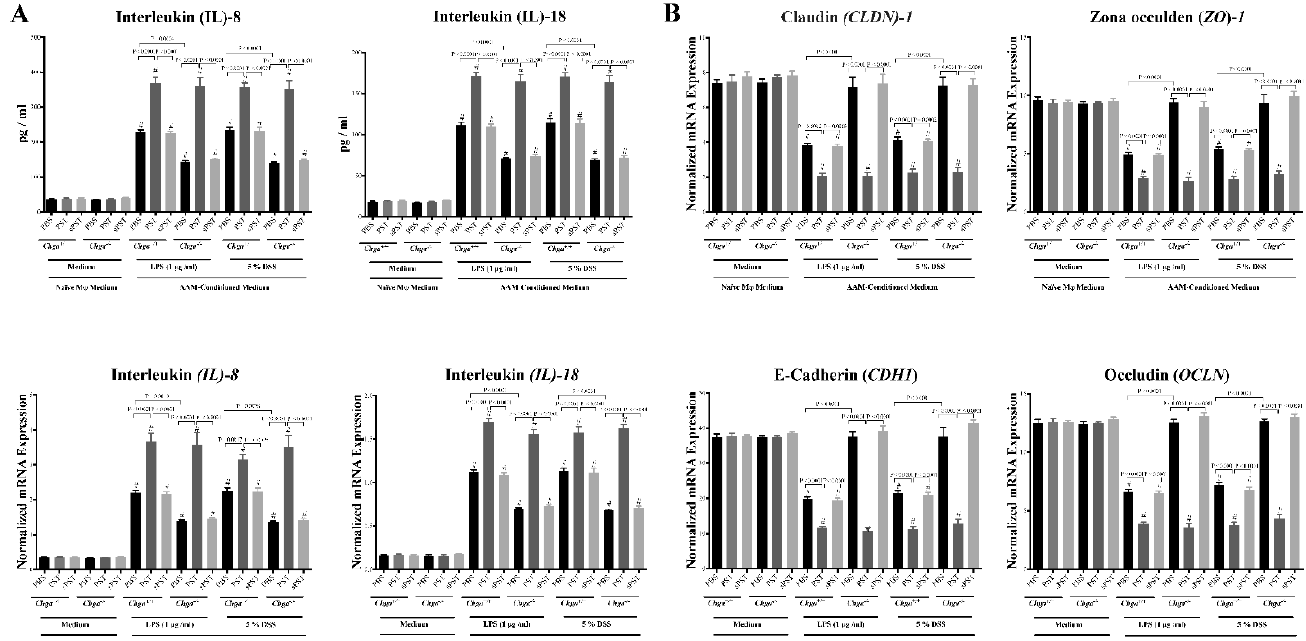
Figure 7. Conditioned medium isolated from pancreastatin (PST) pretreated naïve macrophages polarized toward an alternative-activated macrophages profile (AAM) increases IL-8 and IL-18 release and disrupts TJ proteins expression in Lipopolysaccharide (LPS)- and dextran sulfate sodium (DSS)-stimulated colonic epithelial cells. Peritoneal macrophages were isolated from naïve Chga +/+ and Chga − / − mice. Macrophages were pretreated with PST or sPST (200 ng/mL) or 1% PBS for four hours, then stimulated by interleukin (IL)-4/IL-13 (20 ng/mL) for six hours and conditioned medium was harvested. Caco-2 cells were cultured in 2 mL supernatants of 1% phosphate buffer saline (PBS) or conditioned medium for 24 h, then challenged with LPS (1 µ g/mL) or 5% DSS for 24 h. Cells and supernatants were harvested for analysis. ( A ) Medium IL-8 and IL-18 protein levels and cell mRNA expression. ( B ) Cell mRNA expression of TJ protein (Claudin [ CLDN1 ], zonula occludens-1 [ ZO1 ], E-cadherin [ CDH1 ], occludin [ OCLN ]). ELISA quantified protein level. Quantitative real-time RT–PCR quantified mRNA expression. The relative mRNA expression was determined by calculating the difference in the threshold cycle ( ∆ Ct) method. One-way ANOVA followed by multiple comparison tests. Data represent mean ± SEM ( n = 6). # refers to significance compared with control groups (naïve macrophage medium). Each experiment was repeated at least three times.